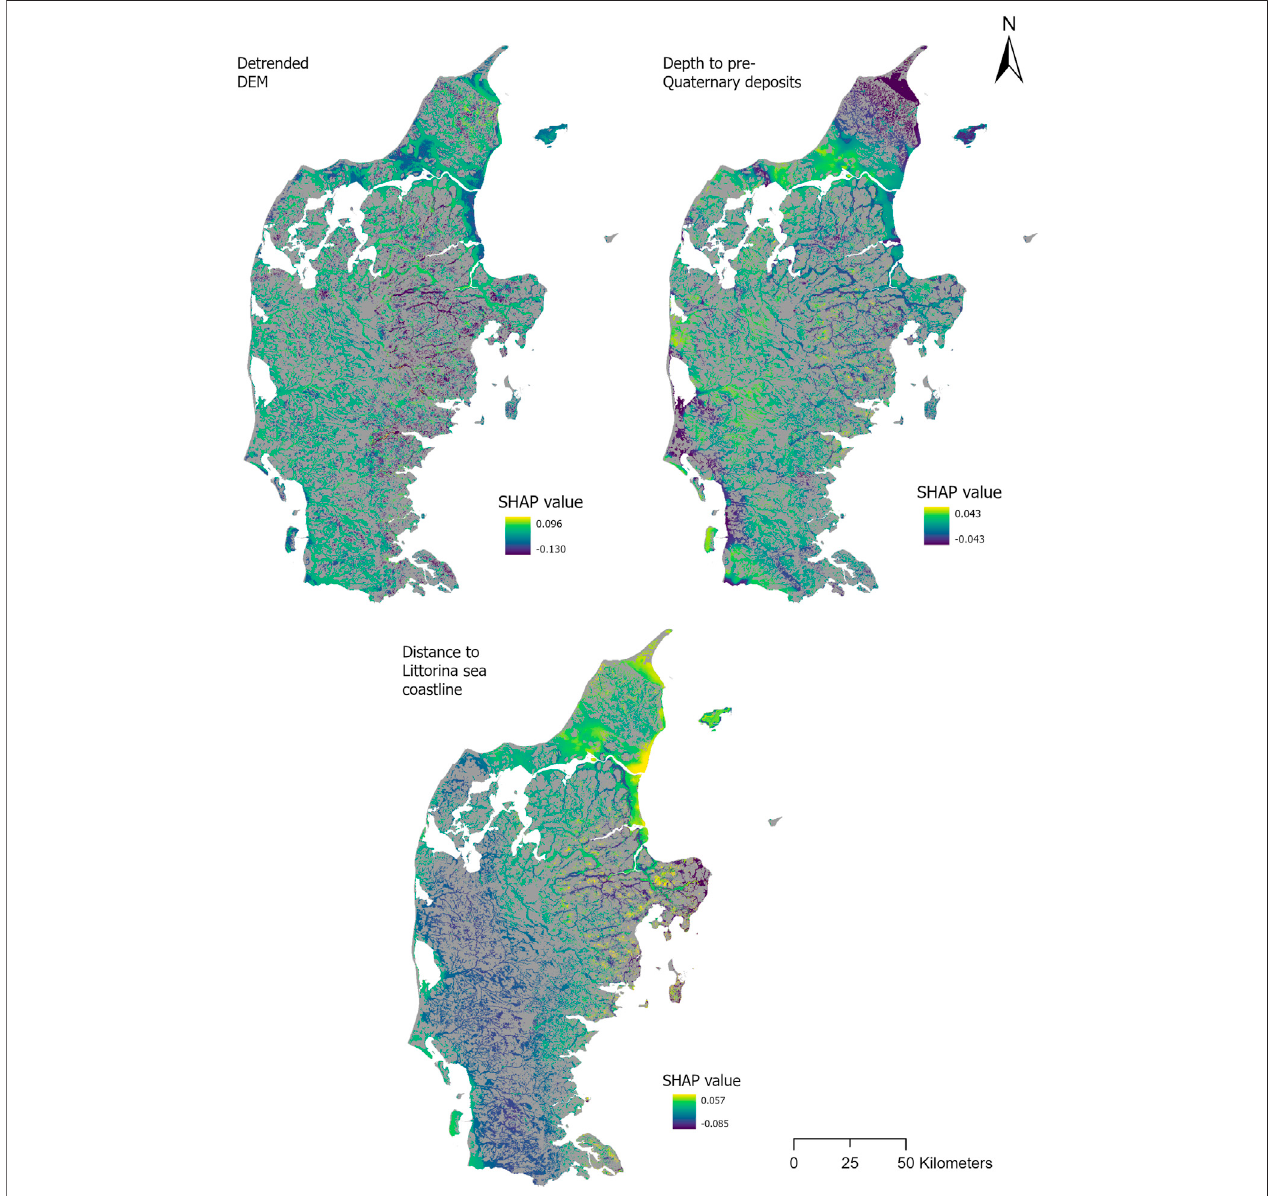
FIGURE9| SpatialdistributionofSHAPvaluesforthethreemostimportantcovariates:detrendedDEM,depthtopre-Quaternarydepositsanddistanceto Littorina sea coastline.